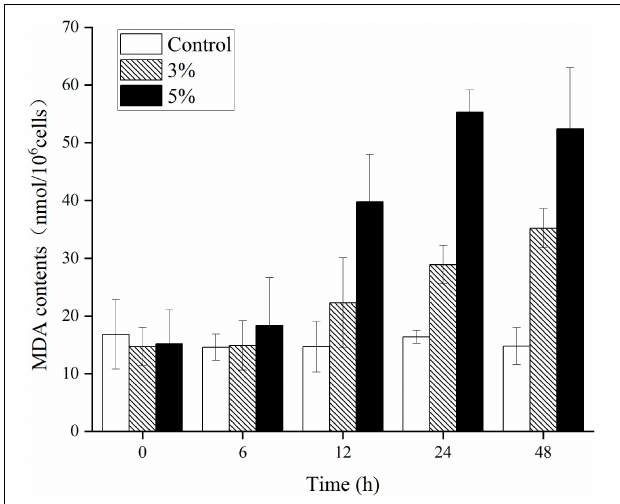
FIGURE 6 | Effects of MDA contents in Karenia mikimotoi after exposure to different volumes of Paracoccus homiensis O-4. Error bars represent the standard deviation of the